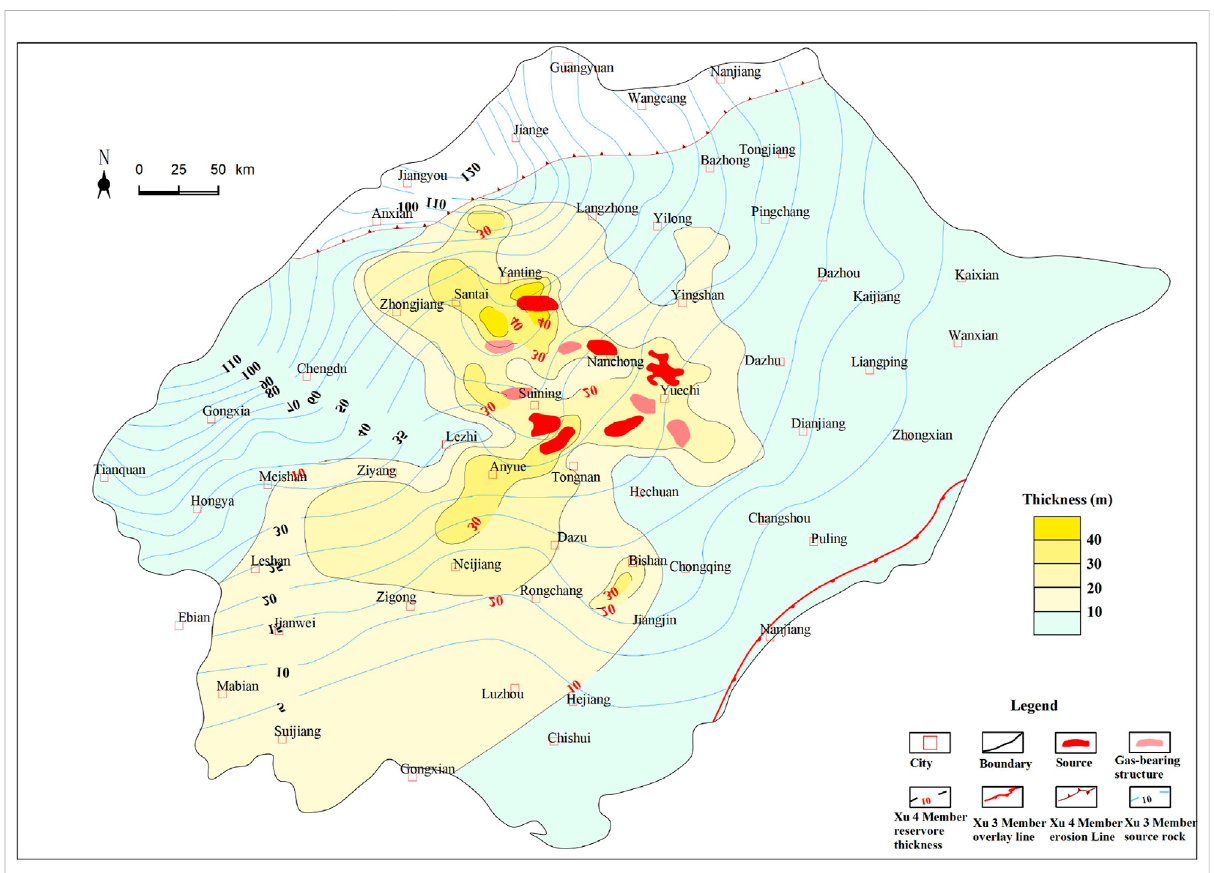
FIGURE 11 Relationship between the thickness of carbonaceous mudstone and coal seam in the Xu 3 Member and the reservoir thickness and natural gas distribution of the Xu 4 Member in the central and western Sichuan